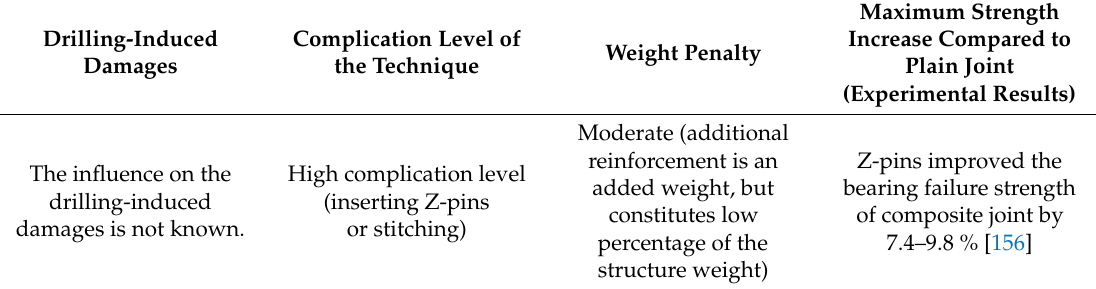
Table 4. Summary of additional reinforcement effect on performance of bolted joints in composite